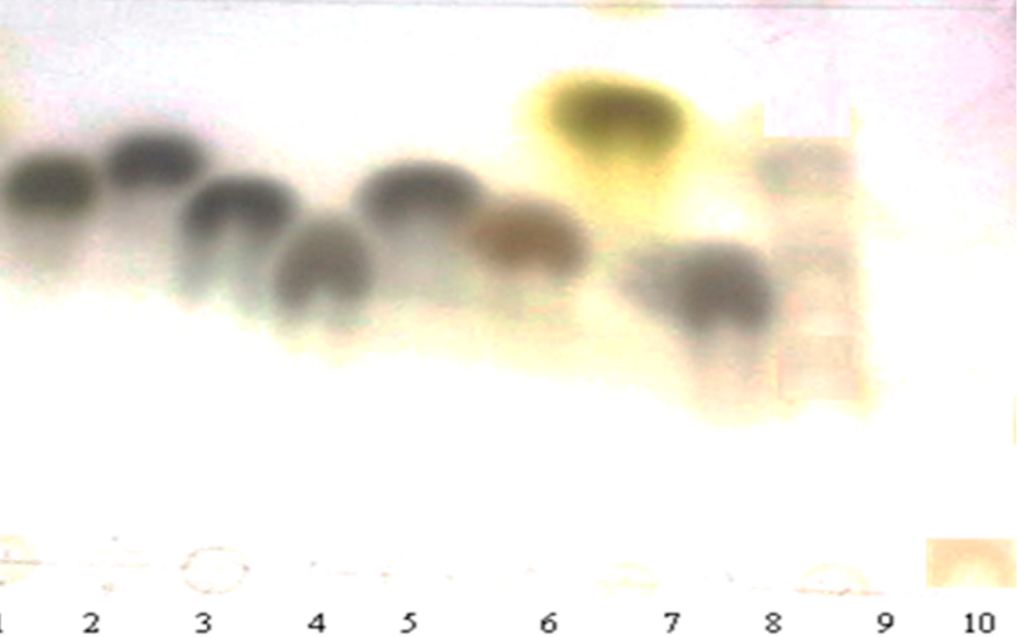
Figure 1. TLC analysis of LWSP. 1. Arabinose, 2. Xylose, 3. Fructose, 4. Glucose, 5. Tagatose, 6. Mannose, 7. Rhamnose, 8. Galactose, 9. LWSP hydrolyzed via TFA, 10. Unhydrolyzed LWSP.